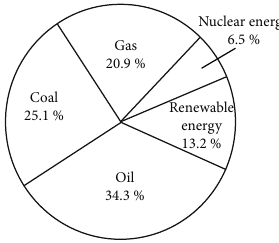
Figure 1: Contribution of each energy source to supply the primary energy in the world.